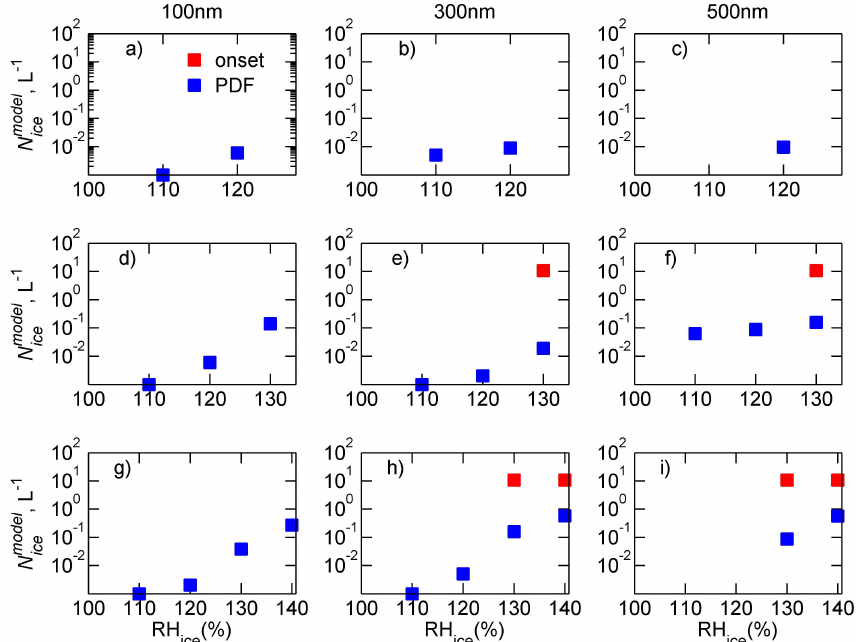
Fig. 6. Comparison of N model calculated by the single onset contact angle and PDF-contact angle approaches under various IN measurement ice conditions (Table 1). (a) to (c) , (d) to (f) and (g) to (i) correspond to − 25, − 30 and − 35 ◦ C,